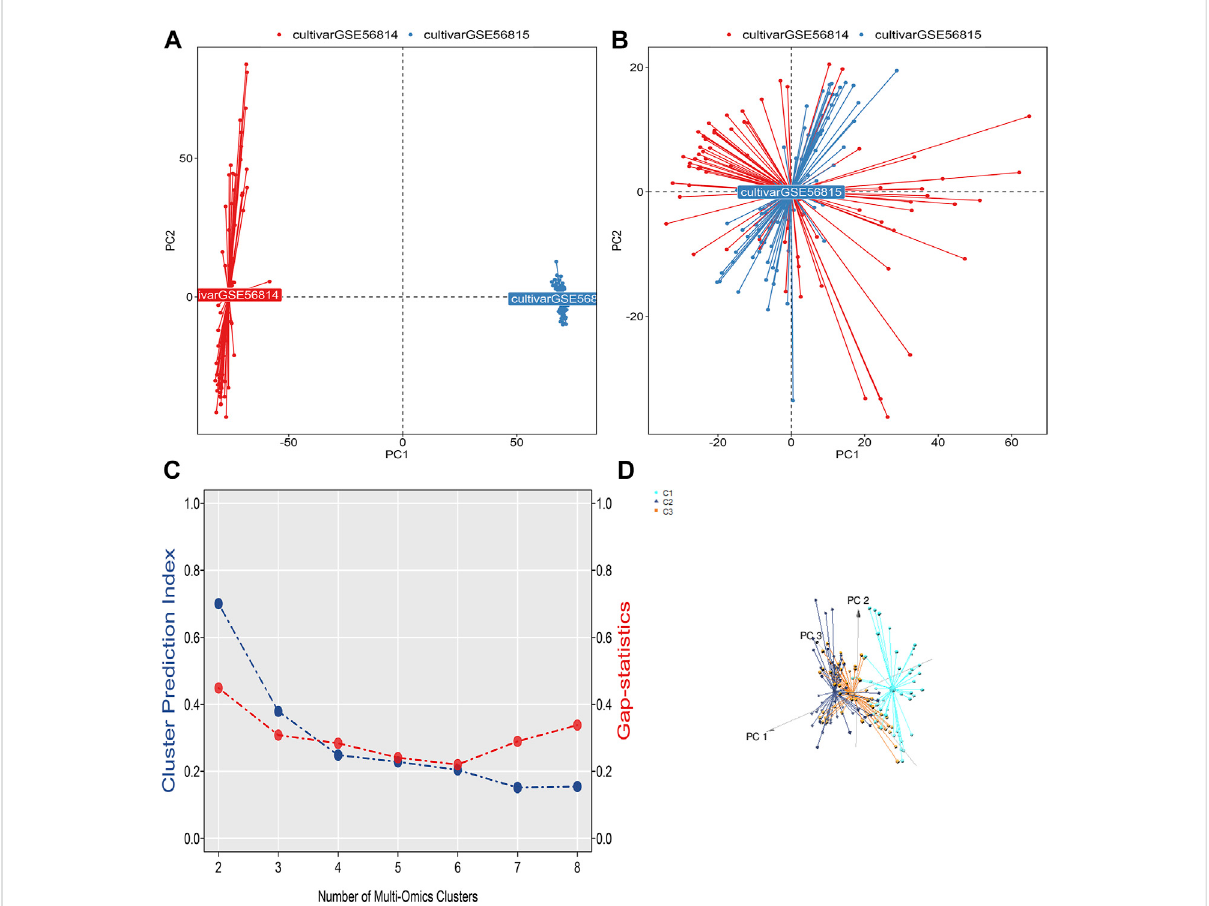
FIGURE 2 (A) Visualization of principal component analysis of expression pro fi les of GSE56814 and GSE56815 datasets. (B) Visualization of principal component analysis of the combined expression pro fi les of GSE56814 and GSE56815. (C) The optimal number of clusters k = 3 was identi fi ed by calculating the CPI (blue line) and gap statistic (red line) in the osteoporosis patient cohort, and the amount of gene expression in osteoporosis patients were classi fi ed into three different subtypes by ensemble similarity network fusion and consensus clustering algorithm (SNF-CC): C1, C2, and C3. (D) Visualization of principal component analysis of three subtype expression pro fi